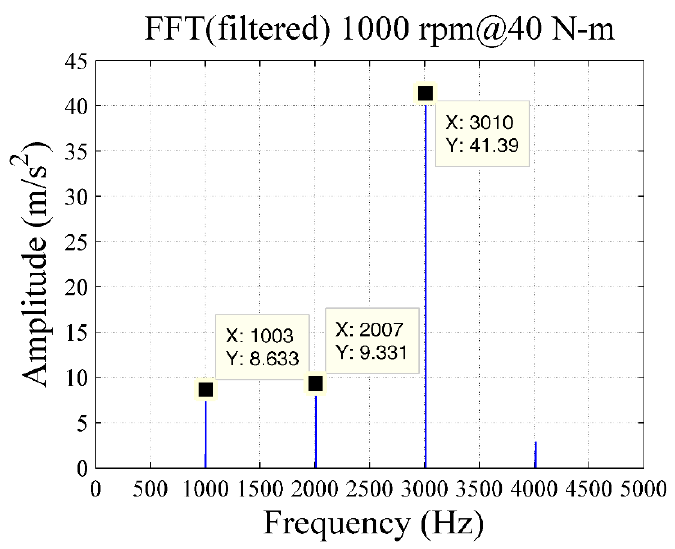
Figure 12. Spectrum of filtered acceleration in the frequency